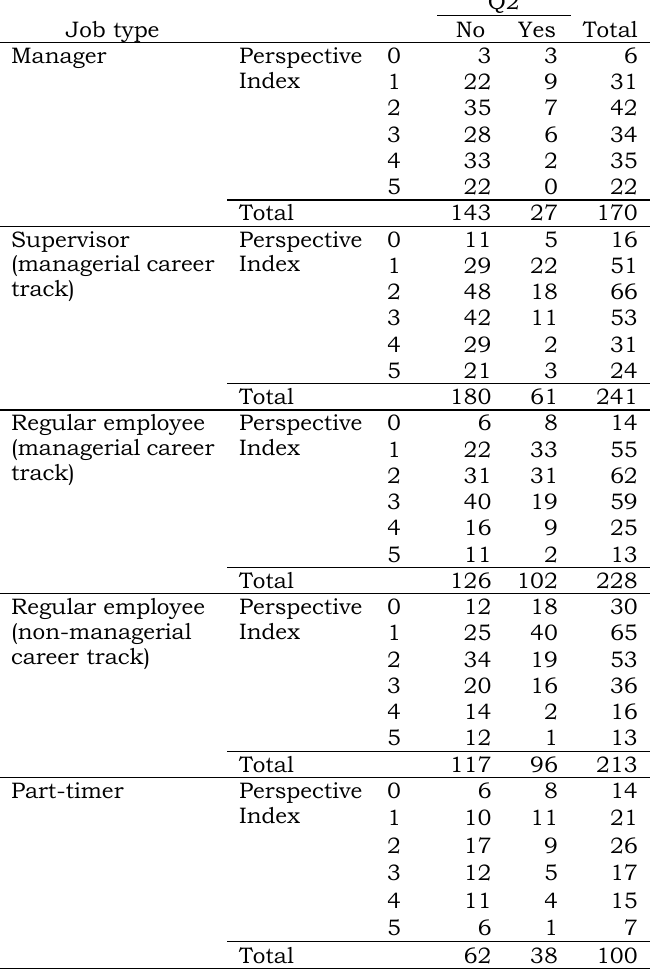
Table 5. Crosstab of job type, perspective index, and turnover